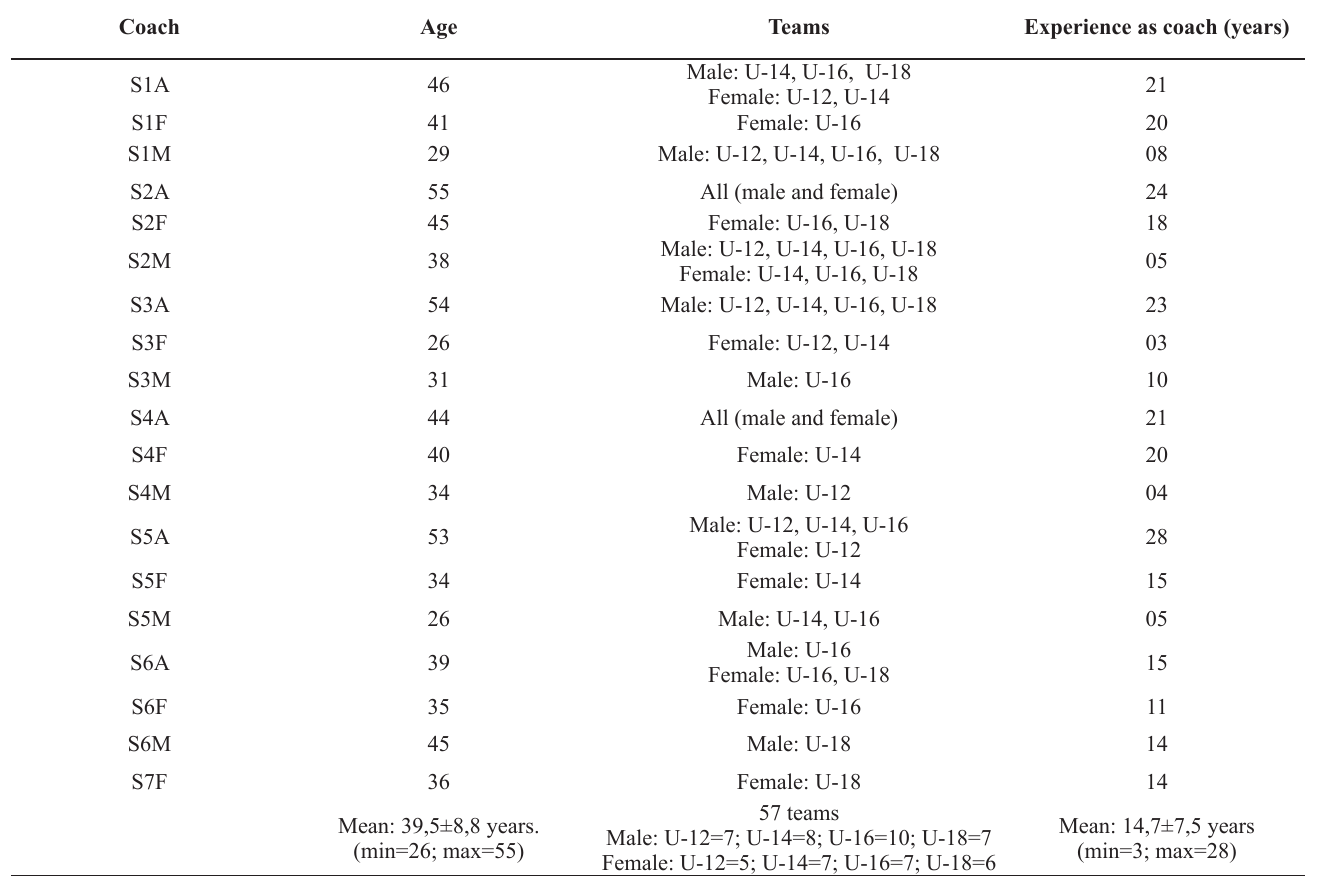
Table 1 - Coaches characteristics